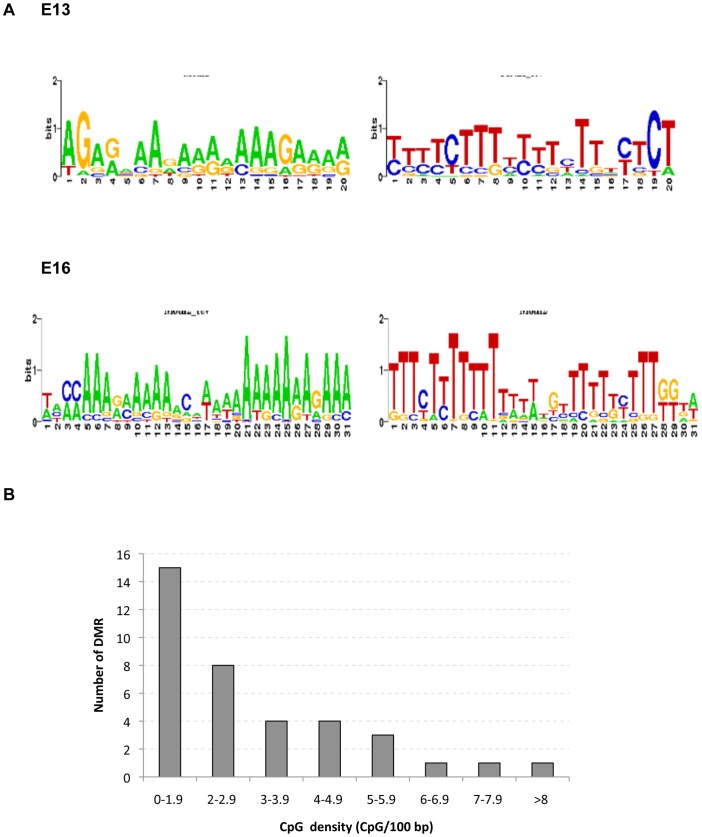
Genomic features of the DMR identified.(A) The forward and reverse sequence motifs obtained with the MEME suite tool GLAM2 for the vinclozolin induced transgenerational DMR from E13 and E16 F3 generation germ cells. (B) Shows the distribution of CpG sites (CpG/100bp) in vinclozolin induced transgenerational DMR obtained from both the E13 and E16 germ cells.